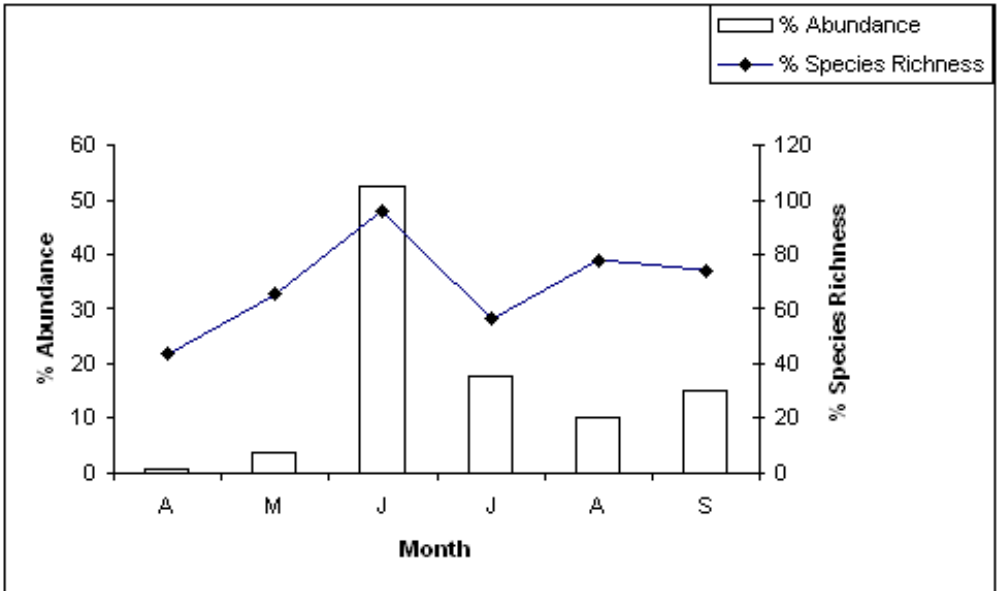
Figure 2. Temporal variations in the % species richness and